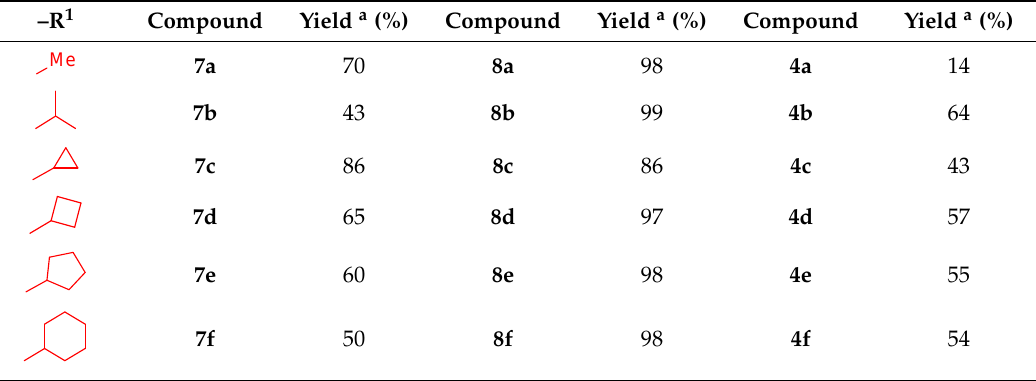
Table 2. Chemical structures (R 1 ) and yields obtained for the synthesis of series 7a – f , 8a – f , and 4a – f .